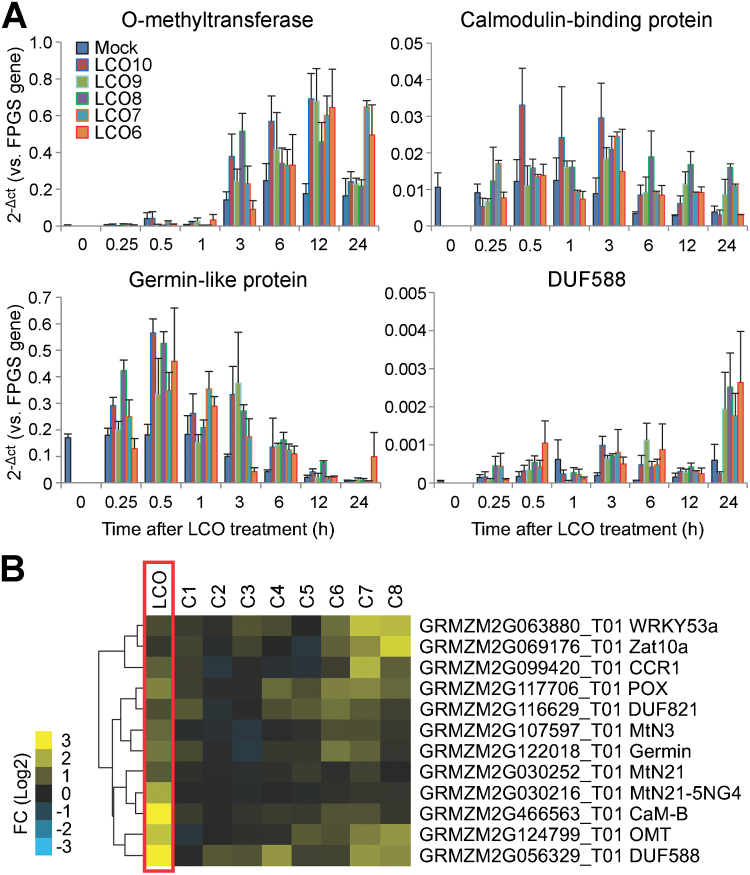
qRT-PCR analysis of LCO-up-regulated genes. (A) Dose- and time-dependent kinetics of LCO-up-regulated genes. LCO10 to LCO6 represent 10-10 to 10–6 M LCO concentrations. (B) Specificity test of LCO-up-regulated genes. Seedlings were incubated for 3h with LCO or chitin oligomers of increasing length (i.e. N-acetylglucosamine to chitooctaose). WRKY53a and Zat10a, homologs of Arabidopsis chitin responsive genes, were used as negative controls (LCO-nonresponsive). C1-C8: chitin monomer to octamer. All chemicals are used at concentration of 10nM. FC: fold change. Data were normalized by the reference gene, FPGS, and then converted to 2-ΔCt (A) or Log 2 of 2-ΔΔCt values as fold change, FC (B). See ‘Materials and methods’ in details.